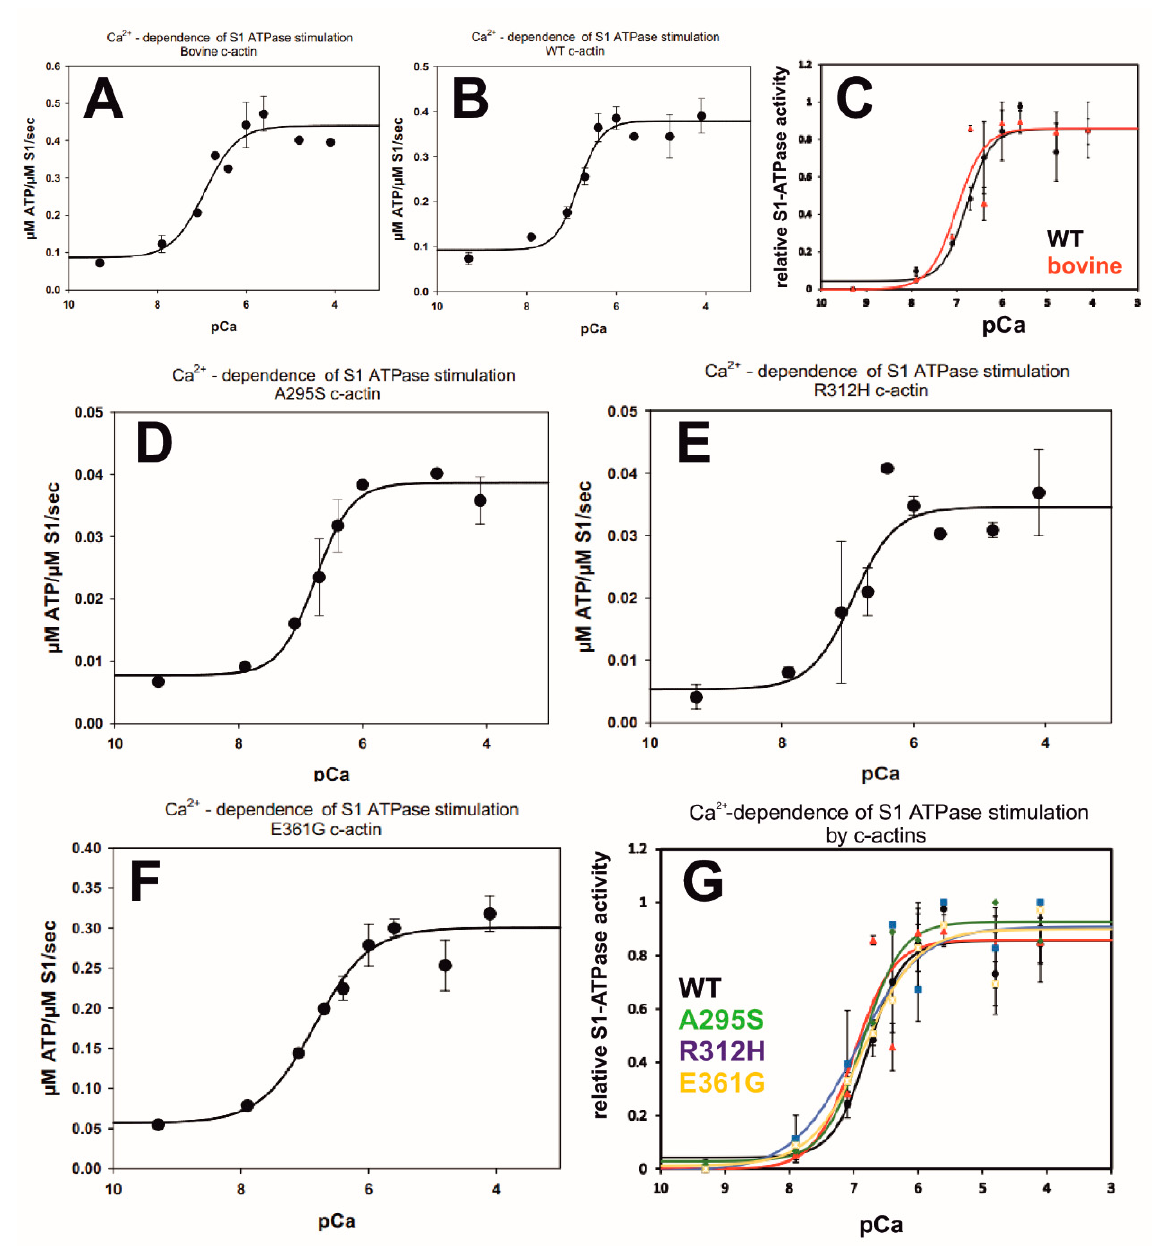
Figure 6. Ca 2+ -concentration dependence of the stimulation of the myosin-S1 ATPase by c-actins decorated with cTm and cTn at a 6:1:1 molar ratio. ( A ) Bovin c-actin, ( B ) WT recombinant actin, ( C ) Bovine vs. WT recombinant actin, ( D ) A295S c-actin, ( E ) R312H c-actin, ( F ) E361G c-actin, ( G ) mutant actins vs. WT recombinant actin. The pCa 50 values and differences in Hill coefficients are compiled in Table 2. These data show that after cTm/cTn decoration, in comparison to wt c-actin and the two DCM mutants, the p.A295S mutant possessed a higher Ca 2+ -sensitivity. The Hill coefficients (Table 3) appeared to be rather similar for wt and the p.A295S mutant, however, the DCM mutants p.R312H and p.E361G and bovine c-actin showed lower Hill coefficients (i.e., the ability for cooperative propagation of myosin-S1 binding along the actin filament). The reduced Hill coefficient of the DCM mutants might be due to the fact that the p.R312H and p.E361G mutations are located within the cTm and myosin head binding regions, respectively (see also